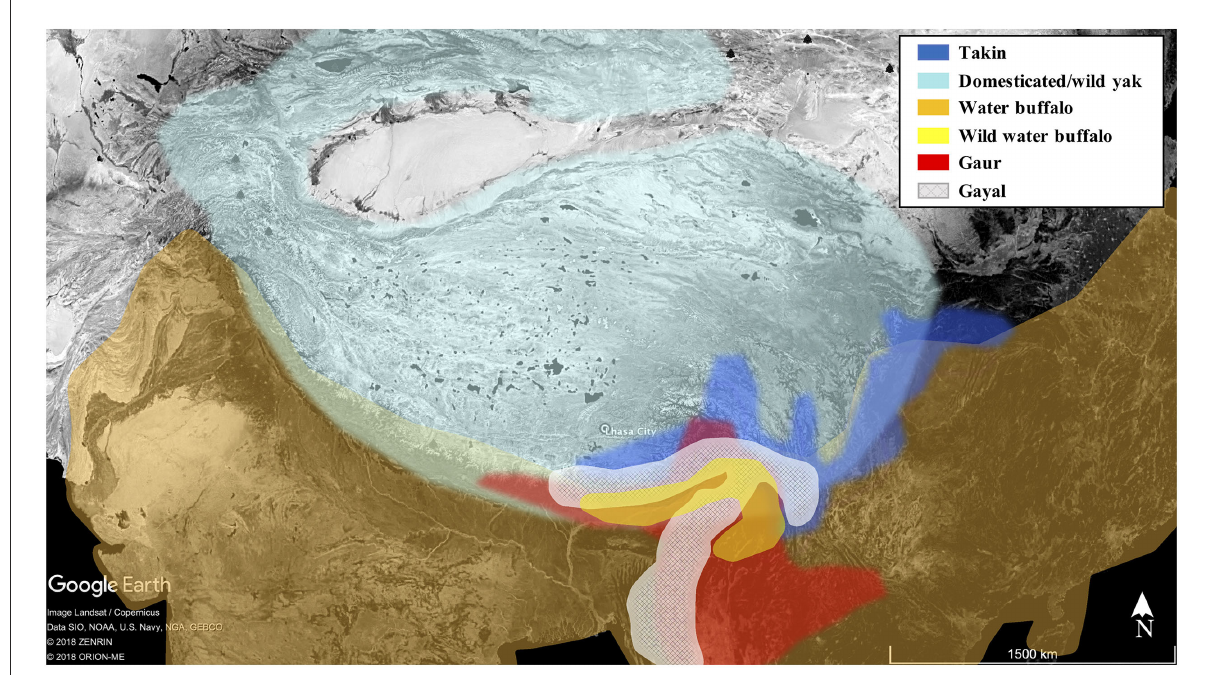
FIGURE1 Approximate distributions of extant large bovids of the Tibetan Plateau and vicinity (Data from Simoons, 1968; Zhang, 1989; Song et al., 2008; Buzzard and Berger, 2016; Duckworth et al., 2016; Gilbert et al., 2018; Kaul et al., 2019). Cattle (predominantly taurine) are found throughout the